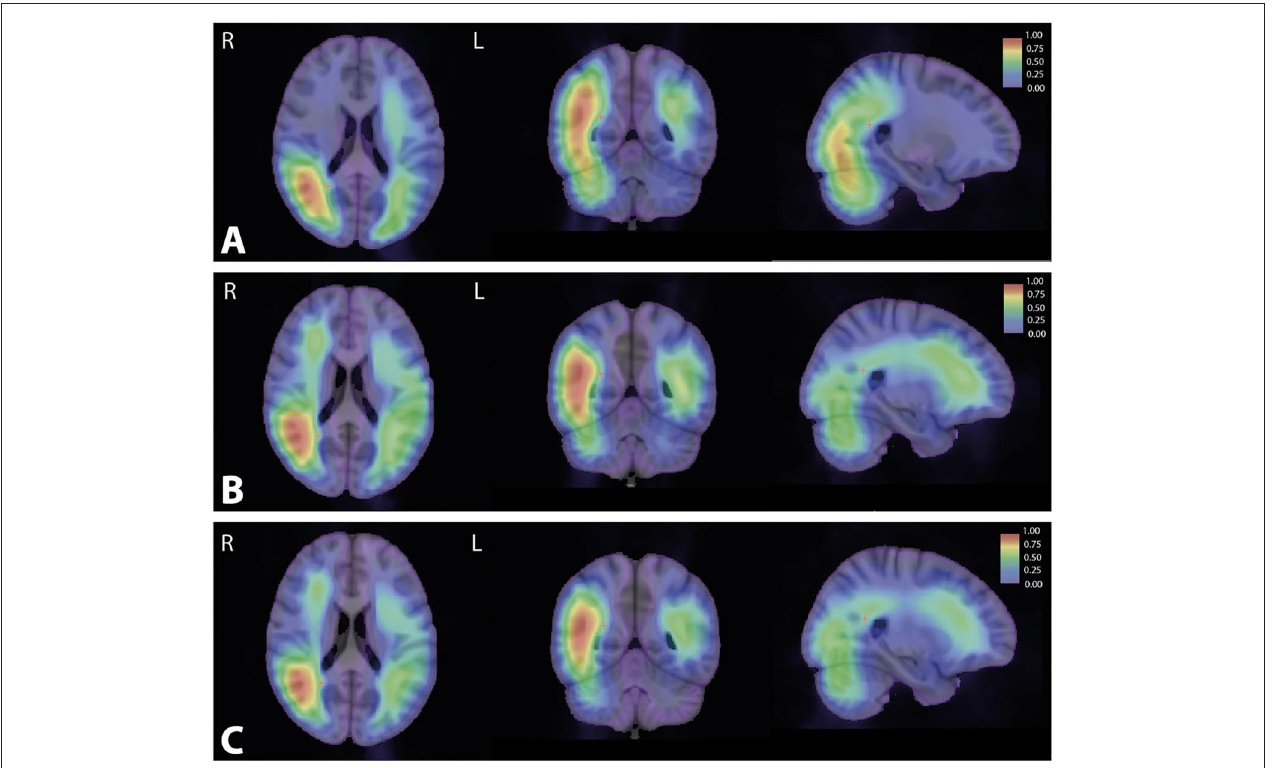
FIGURE 8 | Attention maps computed by Grad-CAM for control, non-amnestic, and amnestic EOAD participants. The resulting averages for each population were overlaid on MNI template space. MNI coordinate of the red cross (25.28, − 82.36, 33.42). (A) Average of the attention map on the control population. (B) Average of the attention map on the non-amnestic EOAD population. (C) Average of the attention map on the amnestic EOAD population. R, right hemisphere; L, left hemisphere; Grad-CAM, Gradient-weighted Class Activation Mapping; EOAD, early-onset Alzheimer’s disease; MNI, Montreal Neurological